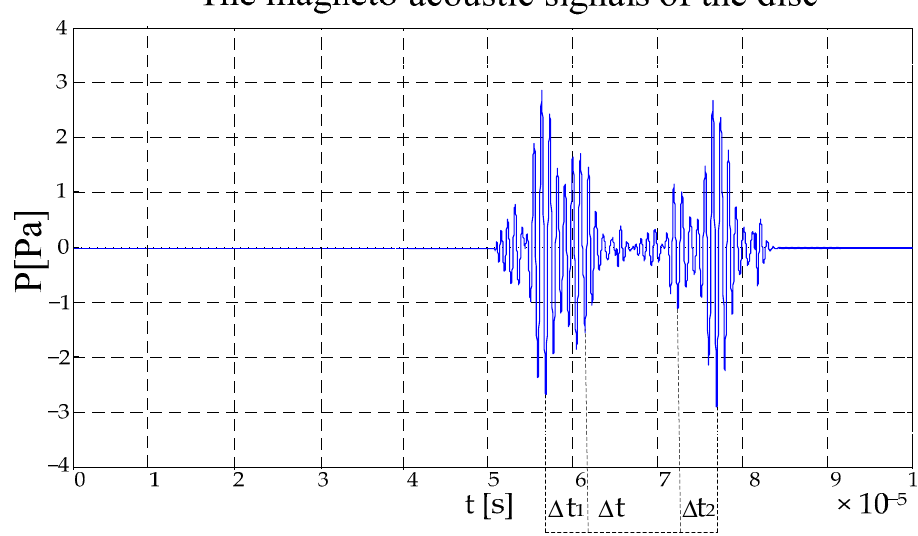
Figure 12. The magnetoacoustic signal waveform of the disc.